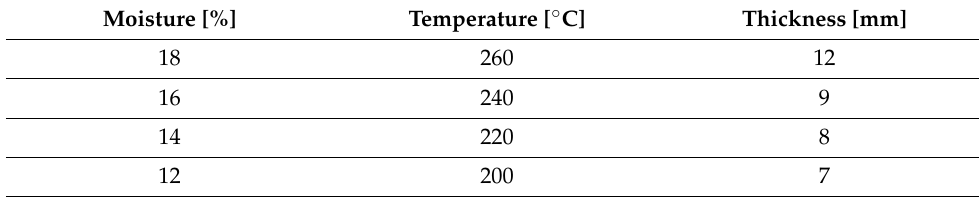
Table 1. Proposed gas separation material with different moisture content and temperature.